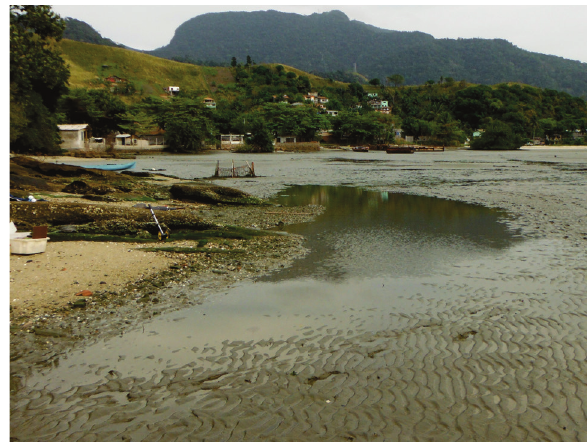
Figure 6. The tide pool in the Araçá Bay where the proposed sampling fish protocol and its capture efficiency were carried out. Photography: Marina R.